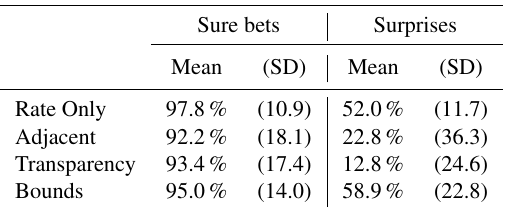
Table 4. Comparative Judgment task: percentage of trials where participants judged the higher-rate location (sure bet trials) or higher-uncertainty location (surprise trials) to have more after- shocks, per